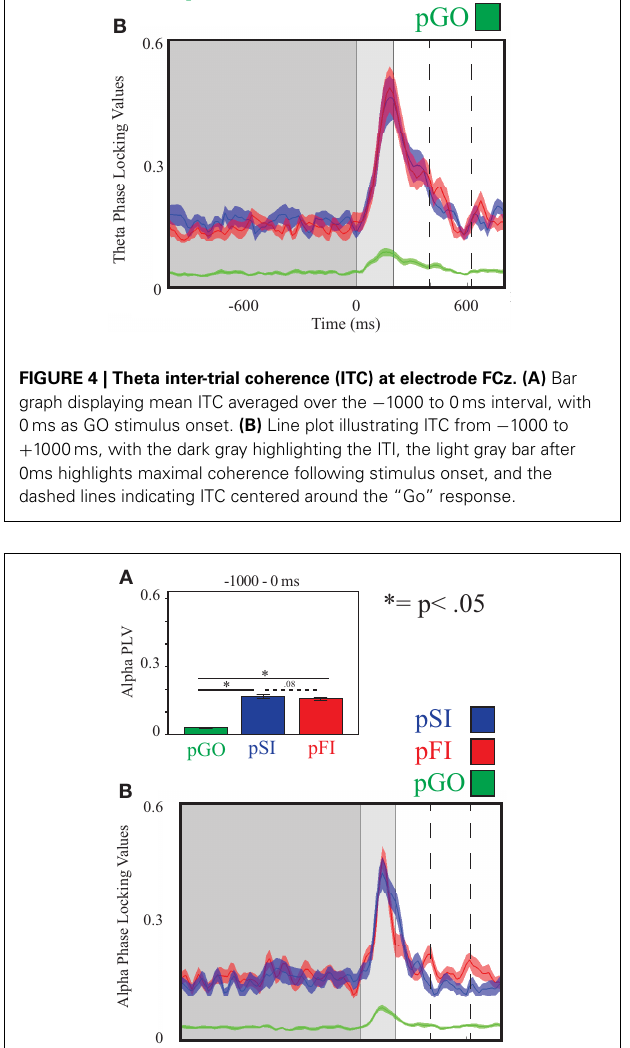
FIGURE 5 | Alpha inter-trial coherence (ITC) at electrode C3. (A) Bar graph displaying mean ITC averaged over the − 1000 to 0ms interval, with 0ms as GO stimulus onset. (B) Line plot illustrating ITC from − 1000 to + 1000ms, with the dark gray highlighting the ITI, the light gray bar after 0ms highlights maximal coherence following stimulus onset, and the dashed lines indicating ITC centered around the “Go”